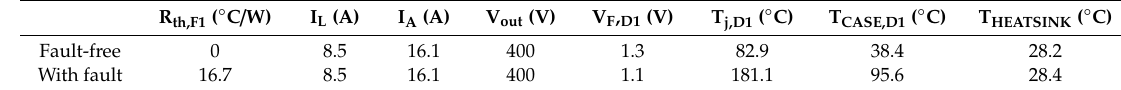
Table 4. Results for the functional test of the diode.